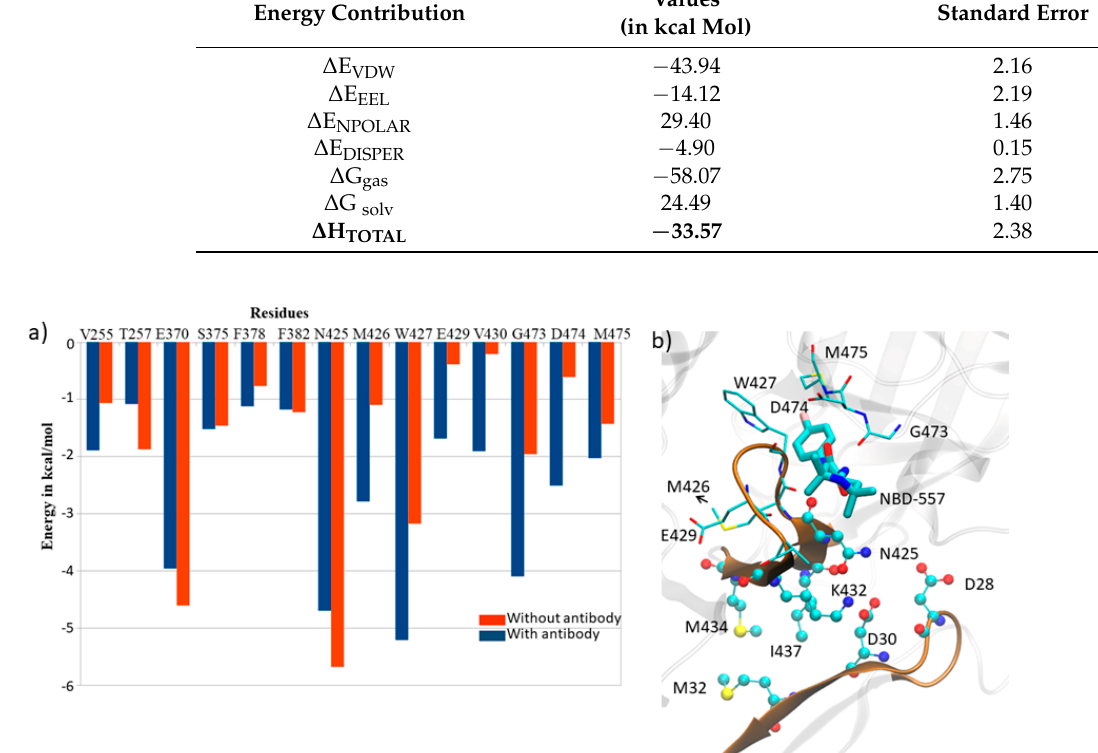
Figure 8. ( a ) A comparative residue interaction map between gp120 and inhibitor NBD-557 in the presence and absence of antibody. ( b ) The representation of residues at the bridging sheet and